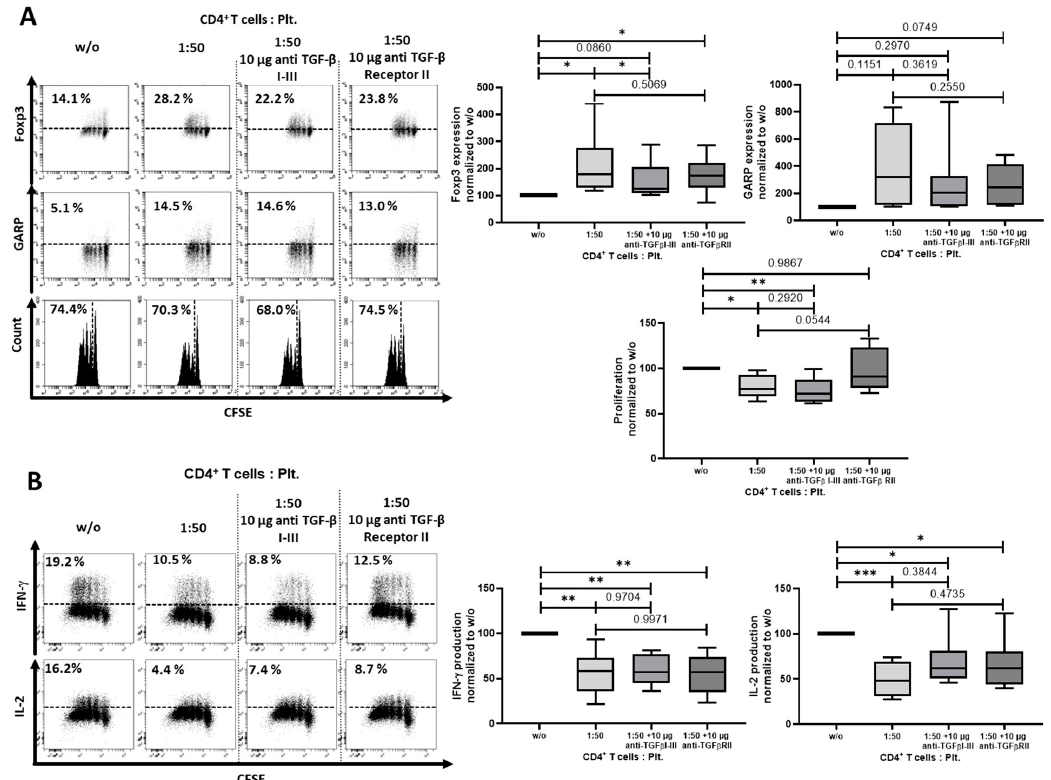
Figure 5. Blockade of transforming growth factor (TGF)- β I-III did in part prevent regulatory T cells (Treg) induction. ( A ) CFSE-labeled CD4 + CD25 - T cells were cocultured with platelets in the ratio of 1:50 and were stimulated with anti-CD3 mAb (0.5 µg/mL) and anti-CD28 mAb (1.0 µg/mL) in the presence of either anti-TGF- β I-III (10 µg/mL) or anti-TGF- β receptor II (10 µg/mL) antibodies. Antibodies were added at day 0. The expression of Foxp3 and GARP and cell proliferation were determined on day 3 via flow cytometry. ( B ) Production of IL-2 and IFN- γ was assessed by intracellular flow cytometry on day 6. The graphs show cells cultured in the presence of platelets normalized to CD4 + CD25 − T cells without platelets. Dot plots show one representative result of 10 independent experiments ( n = 10, box and whiskers, medians ± min/max, * p < 0.05, ** p ≤ 0.01, *** p ≤ 0.001, and n.s. determined by one-way ANOVA).